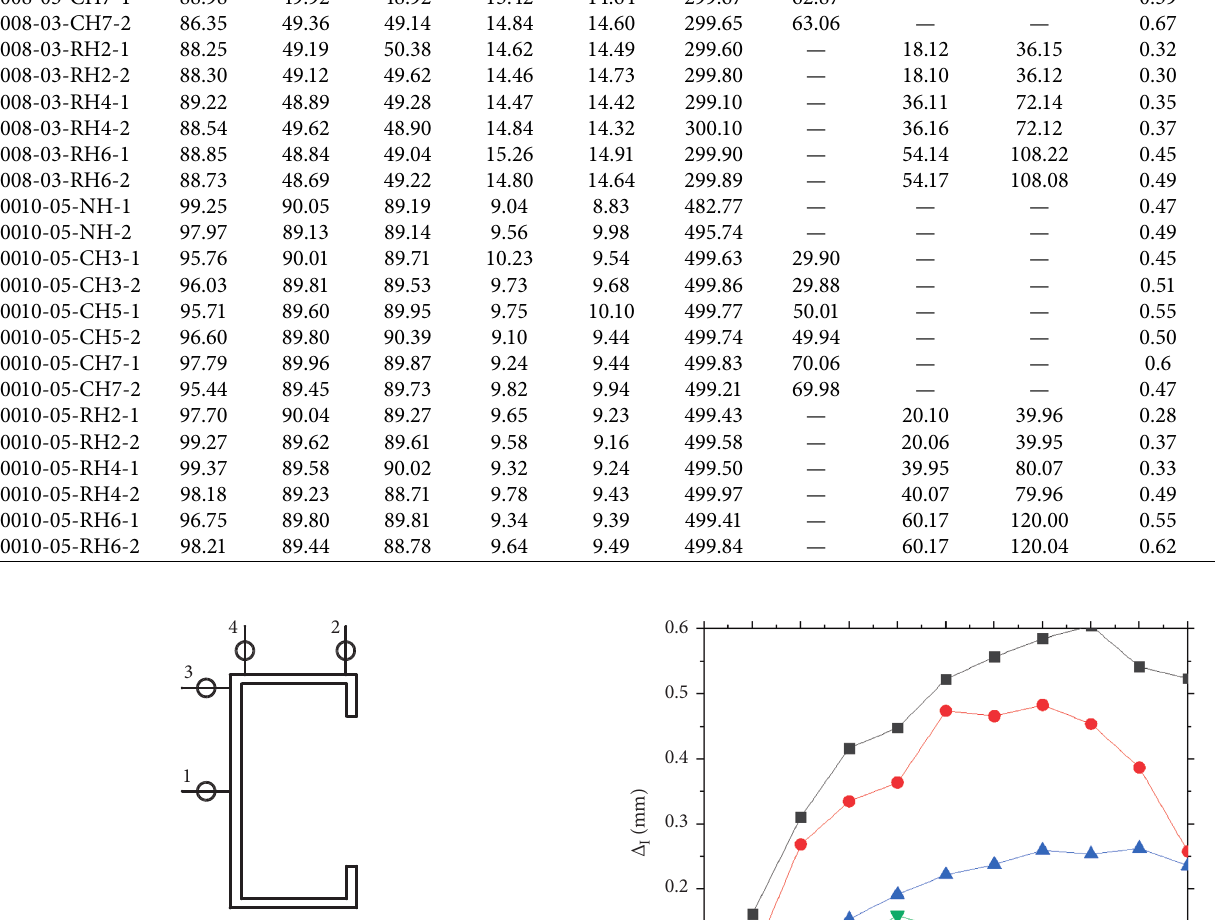
Figure 3: Measure location of initial imperfections.